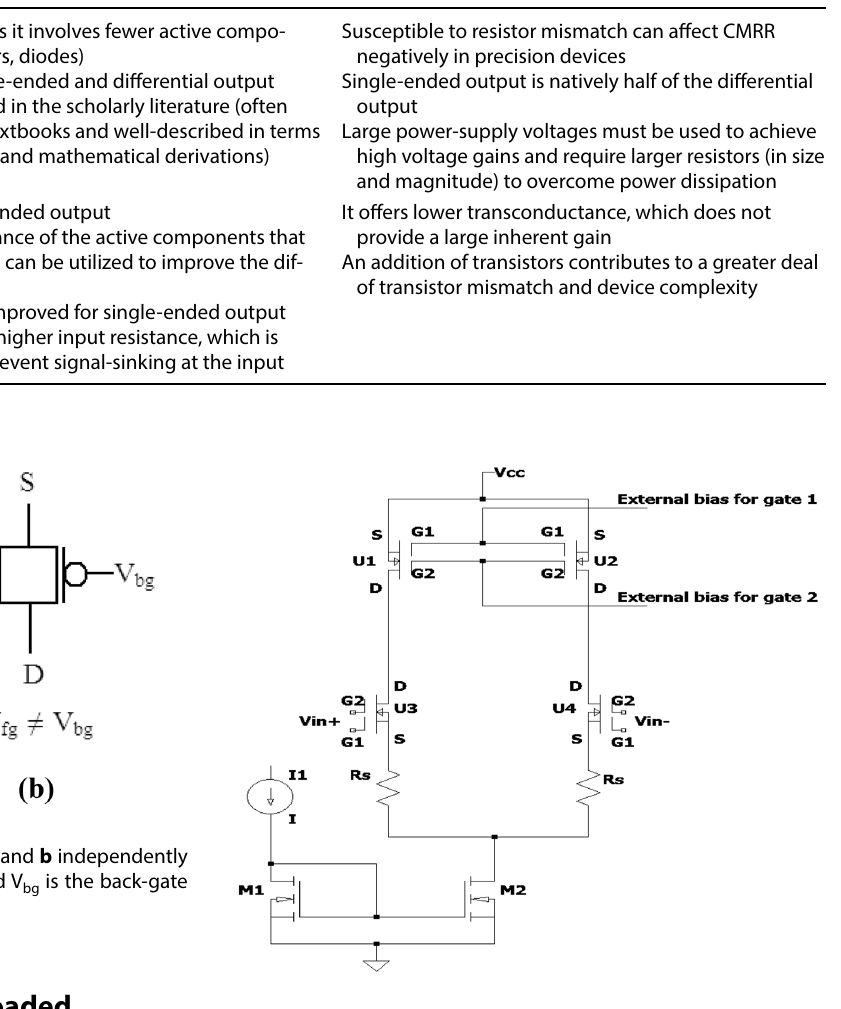
Fig. 5 Active-load differential amplifier topology with the addition of degenerative feedback resistance Rs and NMOS current